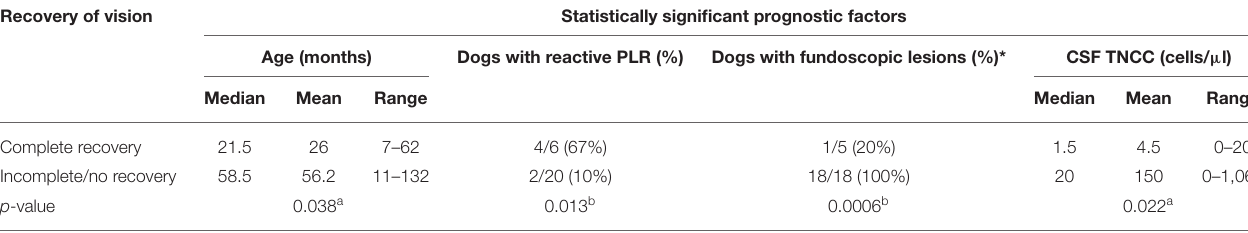
TABLE 1 | Clinicopathologic findings with prognostic value in 26 dogs with ON. Recovery of